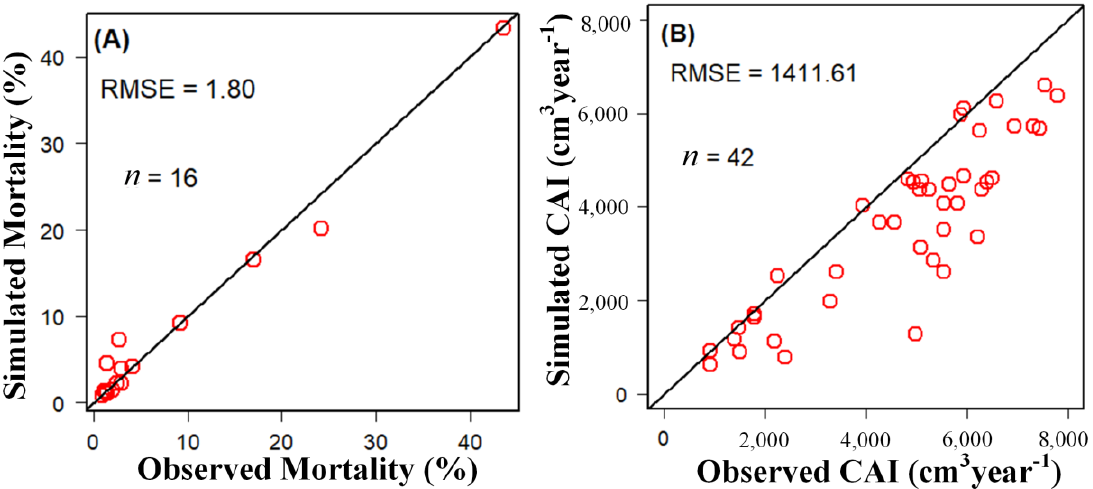
Figure 2. Comparison of observed and simulated values of ( A ) tree mortality (%), and ( B ) the current annual volume increment (CAI) (cm 3 year −1 ).